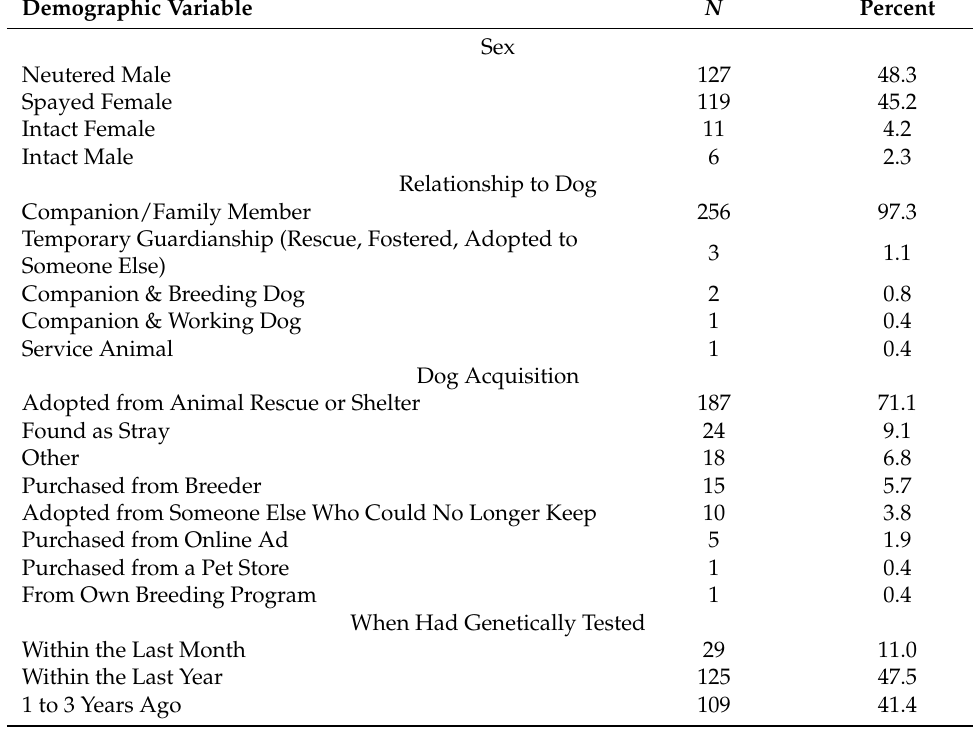
Table 2. Canine demographic variables as self-reported by